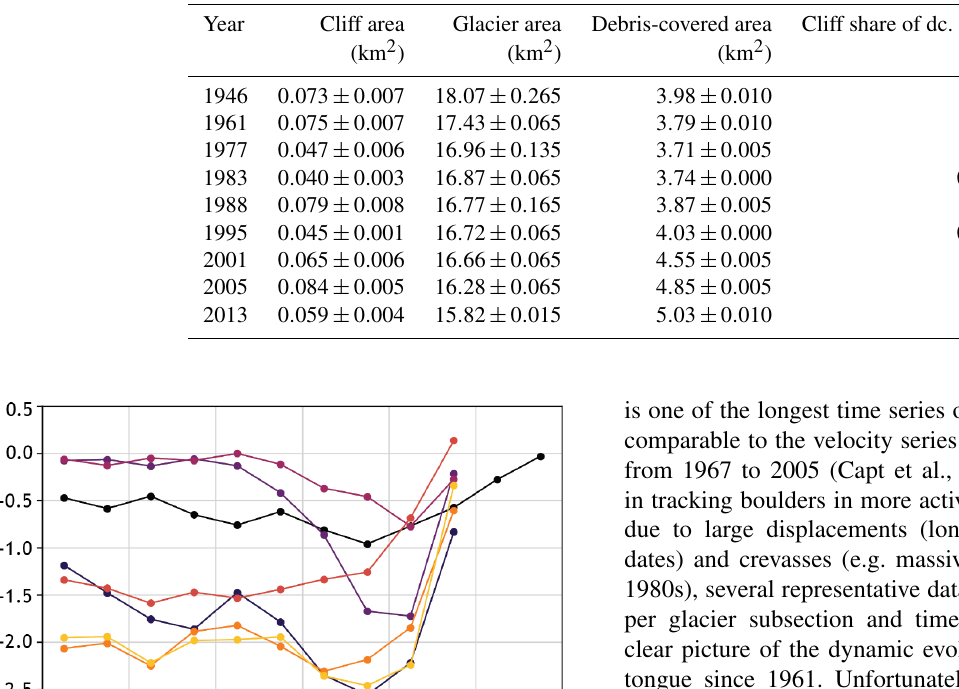
Table 3. Evolution of ice-cliff area from 1946 to 2013; dc.: debris-covered.